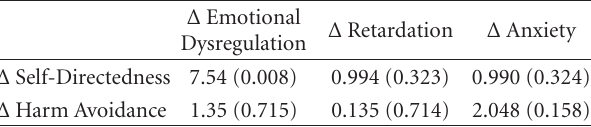
Table 3: The dependence of the change of ( Δ ) Emotional Dysregu- lation, Δ Retardation and Δ Anxiety on Δ Self-Directedness, and Δ Harm Avoidance in 58 patients assessed over 2 years ( F and P values of a MANCOVA).